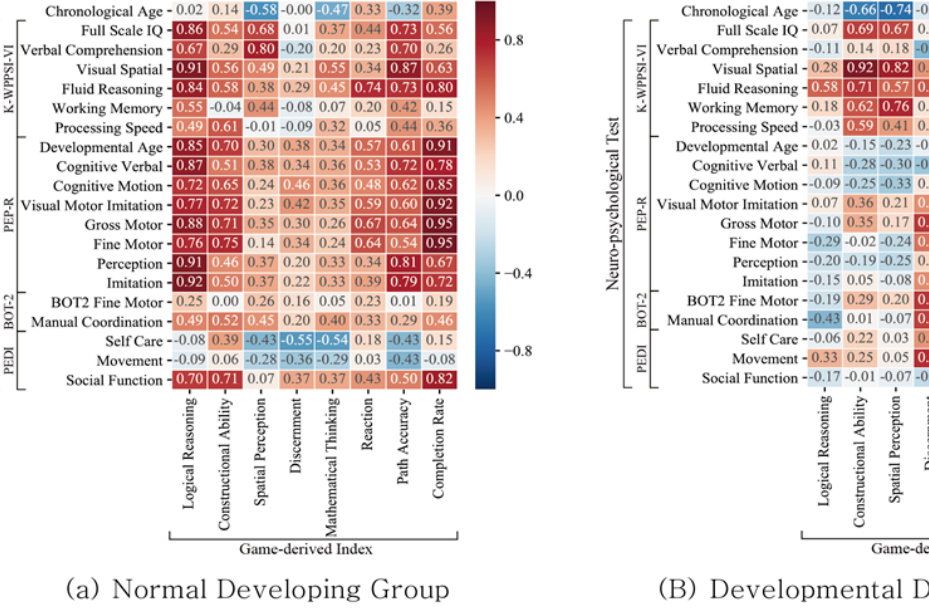
Figure 3. Correlation matrix for the game-derived index and neuropsychological tests of the normal development and developmental disability groups. K-WPPSI-IV: Korean-Wechsler Preschool and Primary Scale of Intelligence; PEP-R: Psychoeducational Profile Revised; BOT-2: Bruininks-Oseretsky Test of Motor Proficiency, Second Edition; PEDI: Pediatric Evaluation of Disability